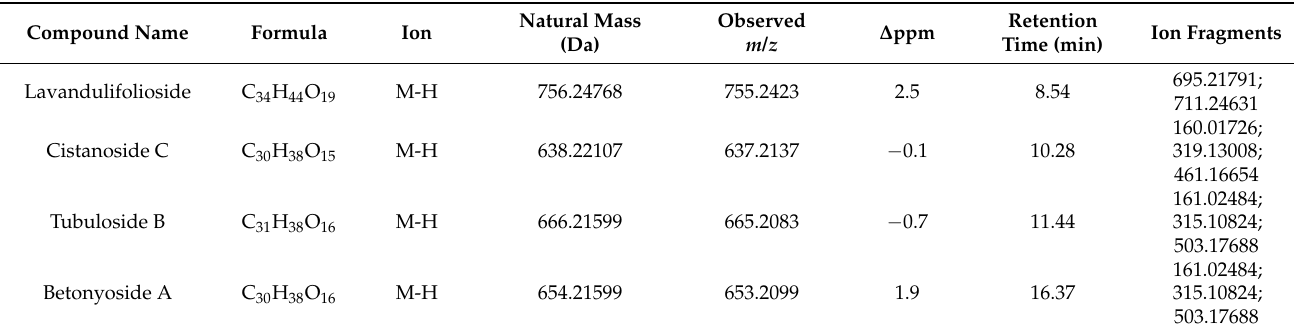
Table 4. Identification of phenylethanoid glycosides compounds in the Barleria lupulina Lindl. leaf extract with MS/MS